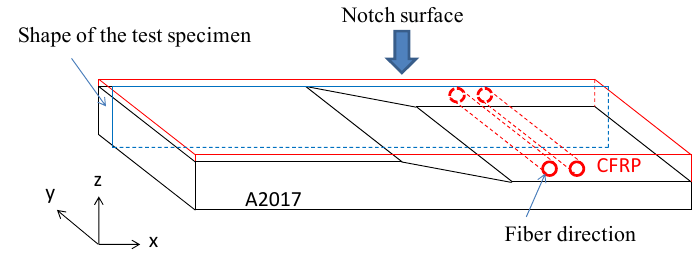
Figure 4: Overview of specimen and direction of fiber.